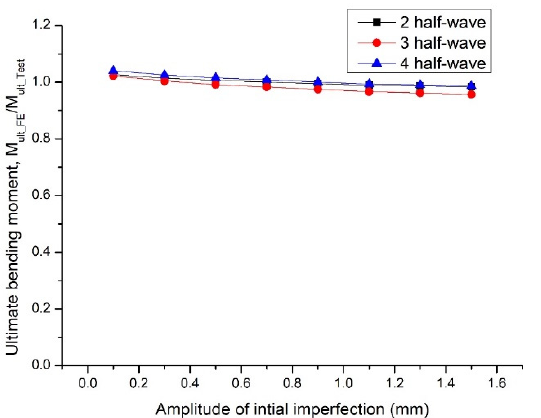
Figure 7. Ultimate bending moment of box girder with various imperfection under static load.